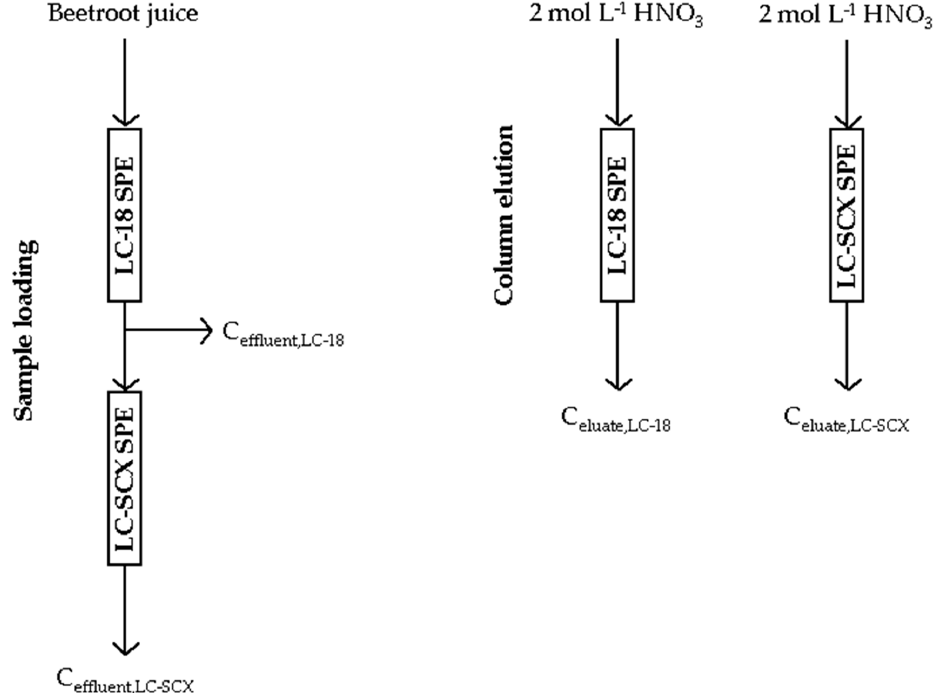
Figure 3. A scheme of the two-column solid-phase extraction (SPE) approach for the chemical fractionation of Cu, Fe, Mn, and Zn in the samples of beetroot juices.